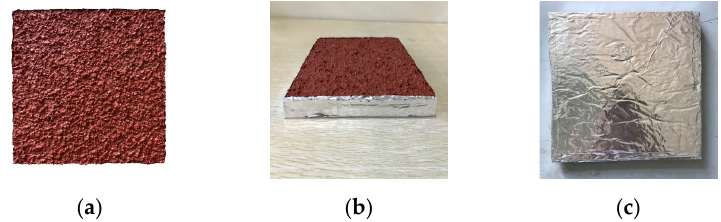
Figure 1. The front ( a ), side ( b ), back ( c ) of a PU athletics track sample sealed and covered with aluminum